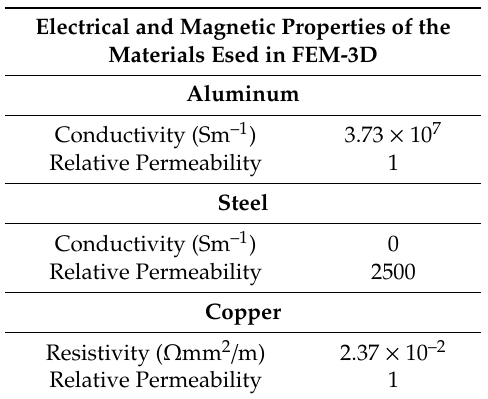
Table 2. Electrical and magnetic